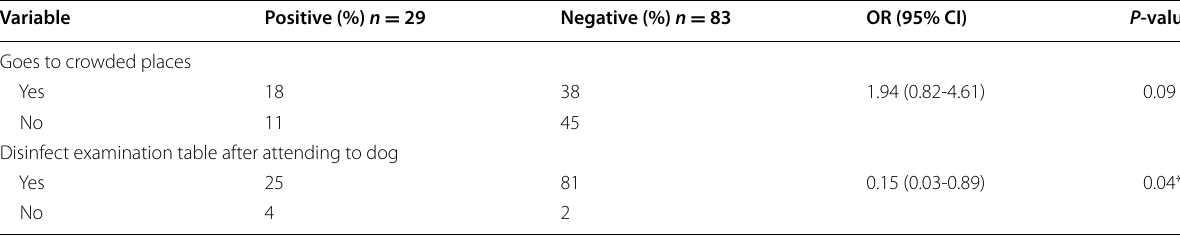
Table 5 Predictors of Covid-19 infection among front line veterinary practitioners in Lagos State, June – August, 2020 ( n Variables